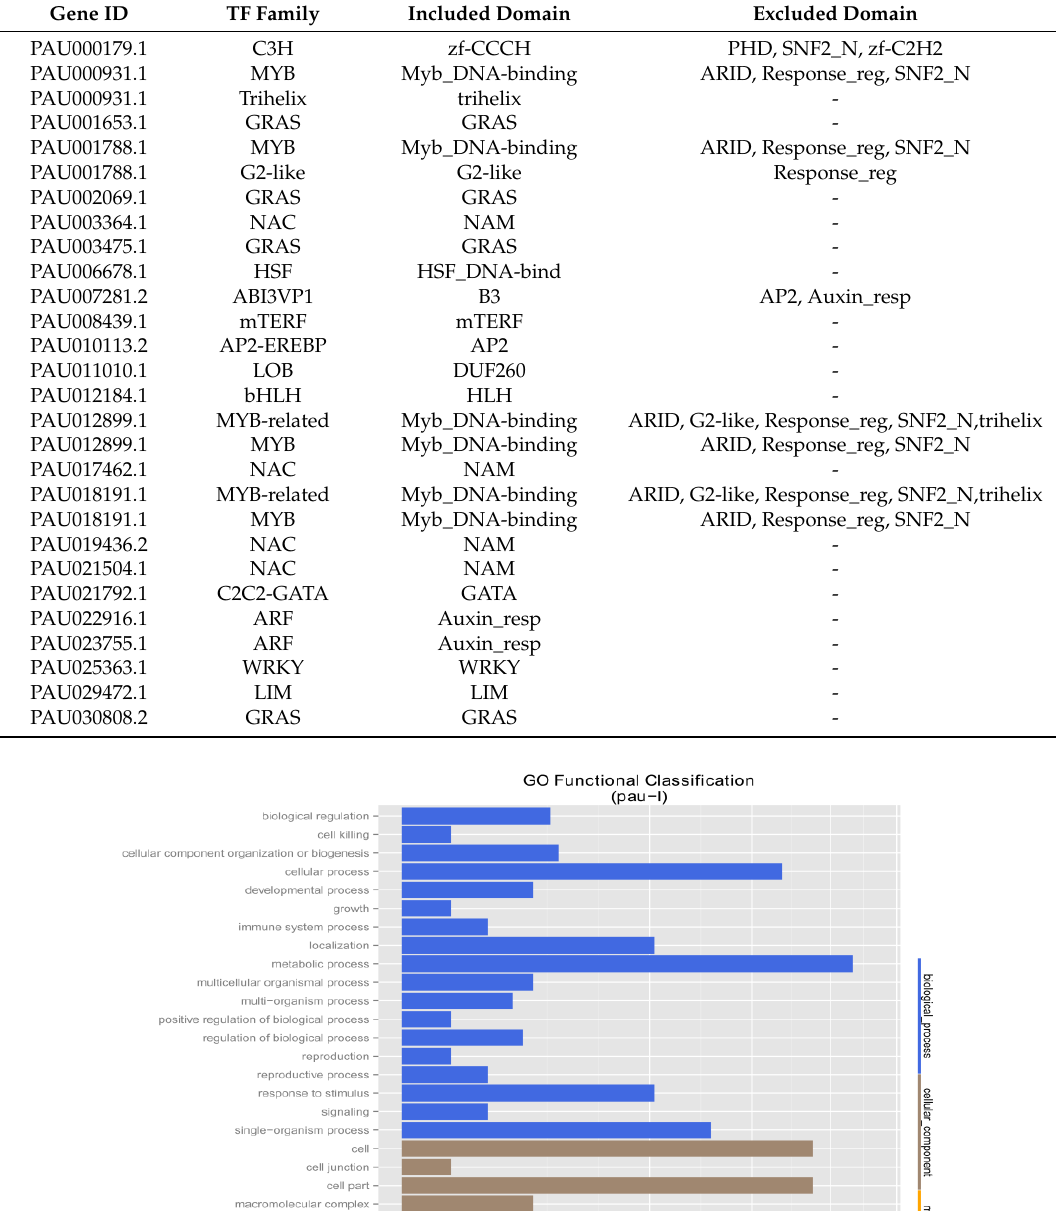
Table 2. The co-expressed DEGs coding the transcription factors.